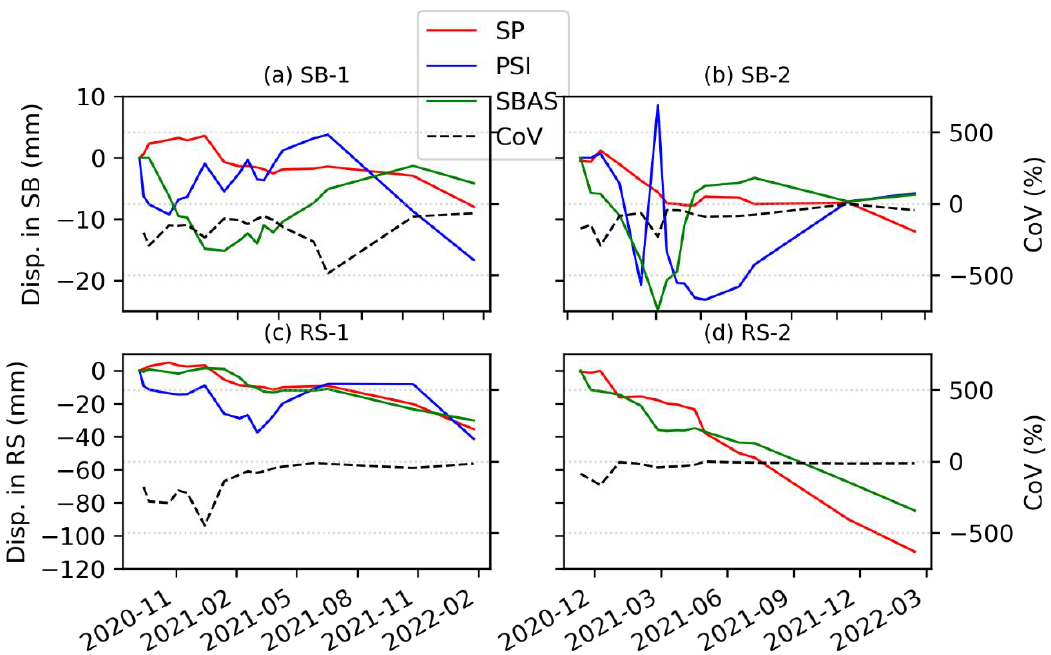
Figure 12. Temporal variation and coefficient of variation in ( a ) SB-1, ( b ) RS-1, ( c ) SB-2, and ( d ) RS- 2.